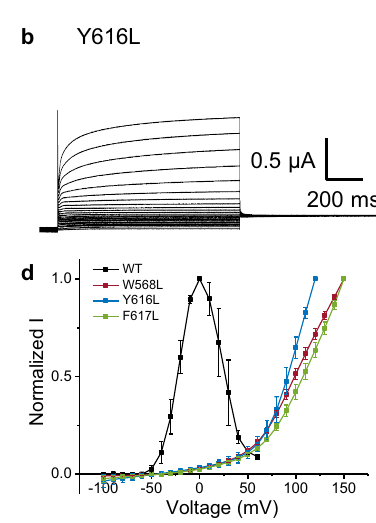
Fig.3|LeucinemutationsatW568,Y616andF617abolishinactivationofhERG. a – c aretherepresentativecurrenttracesfortheW568L,Y616L,F617L,respectively. Insetinaisthevoltageprotocolused.FormutantY616Lthehighestvoltageapplied was+120mV.Becausethosemutantsarerightshifted,wehadtomodifythevoltage